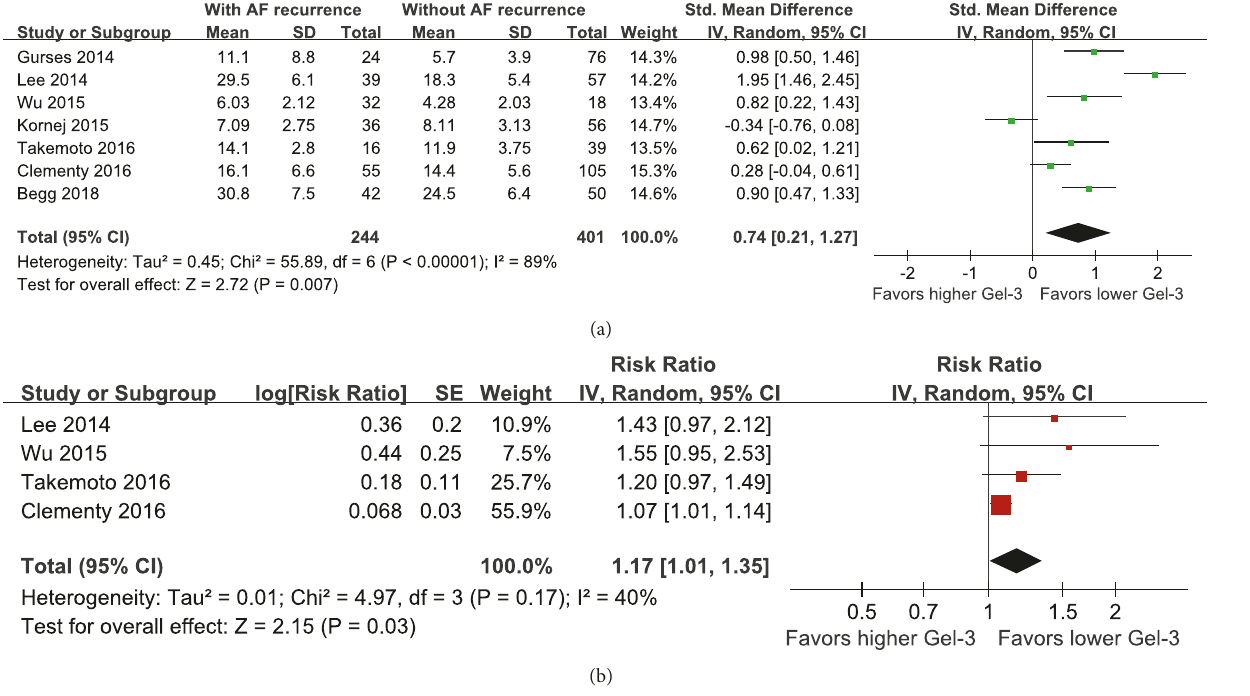
Figure 2: Forest plots showing the association between baseline circulating Gal-3 levels and AF recurrence in patients undergoing catheter ablation.(a)ForestplotsforthedifferencesinbaselineGal-3levelsinpatientswithandwithoutAFrecurrence;(b)forestplotsforthepredictive efficacy of baseline Gal-3 levels for determining the risk of AF recurrence after catheter ablation.